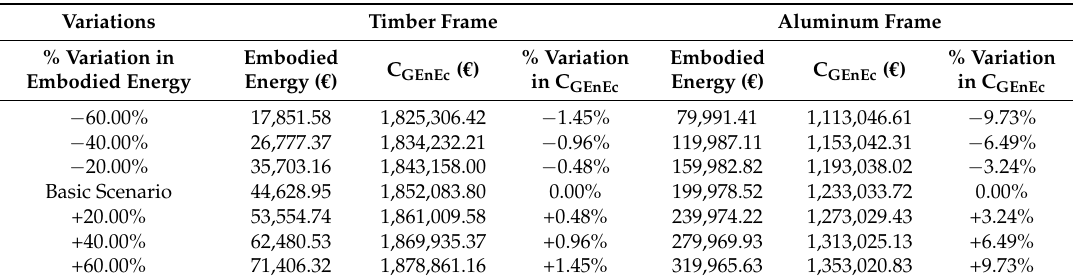
Table 14. Sensitivity analysis with decreased/increased Embodied Energy.